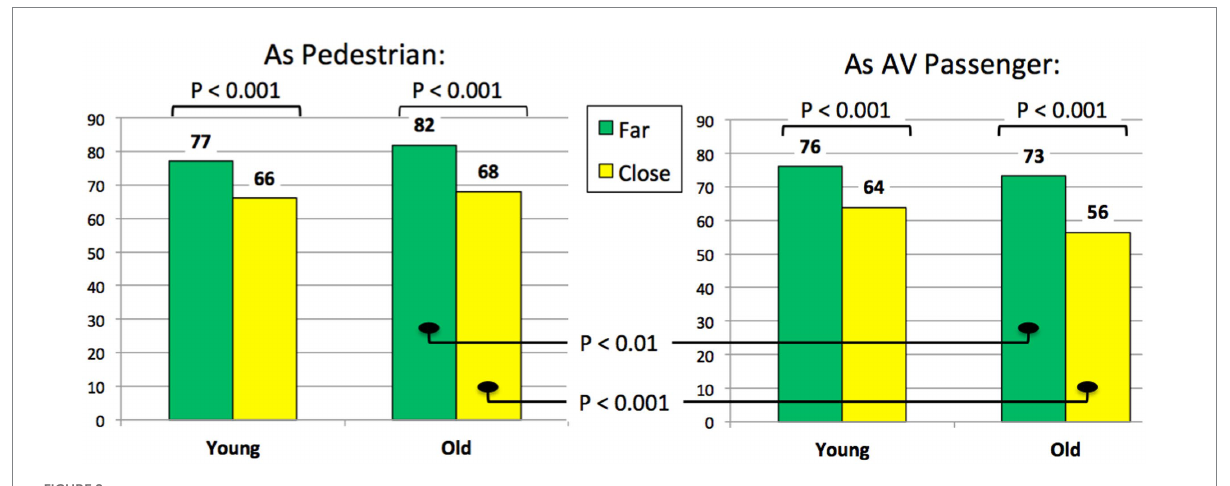
FIGURE 7 Overview of the test procedure.